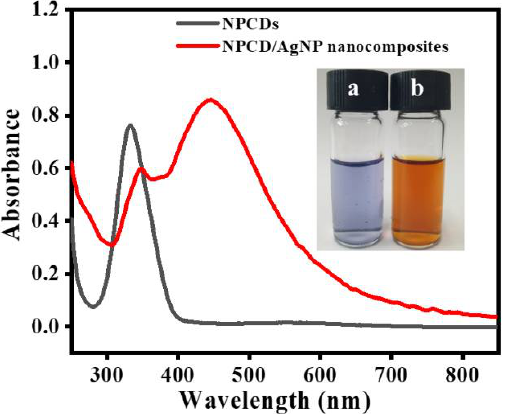
Figure 1. UV–Vis spectra of the aqueous solution of the NPCDs and NPCD/AgNP nanocomposites (inset: color of the aqueous solutions of ( a ) NPCDs and ( b ) NPCD/AgNP nanocomposites).